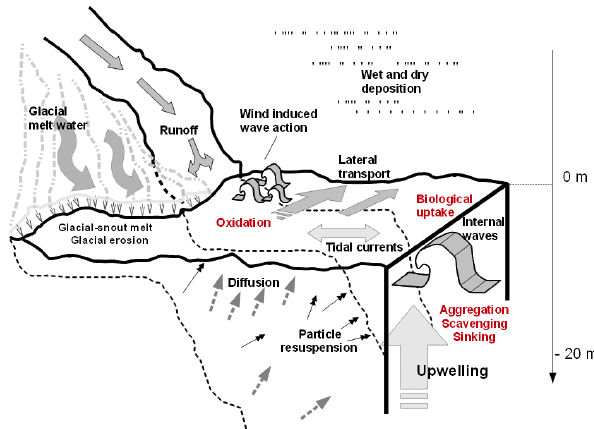
Fig. 11. Schematic overview of the potential coastal and shelf pro- cesses leading to the surface distribution of dFe observed around South Georgia (i.e. Fig. 9). Processes removing dFe from the water column are indicated in